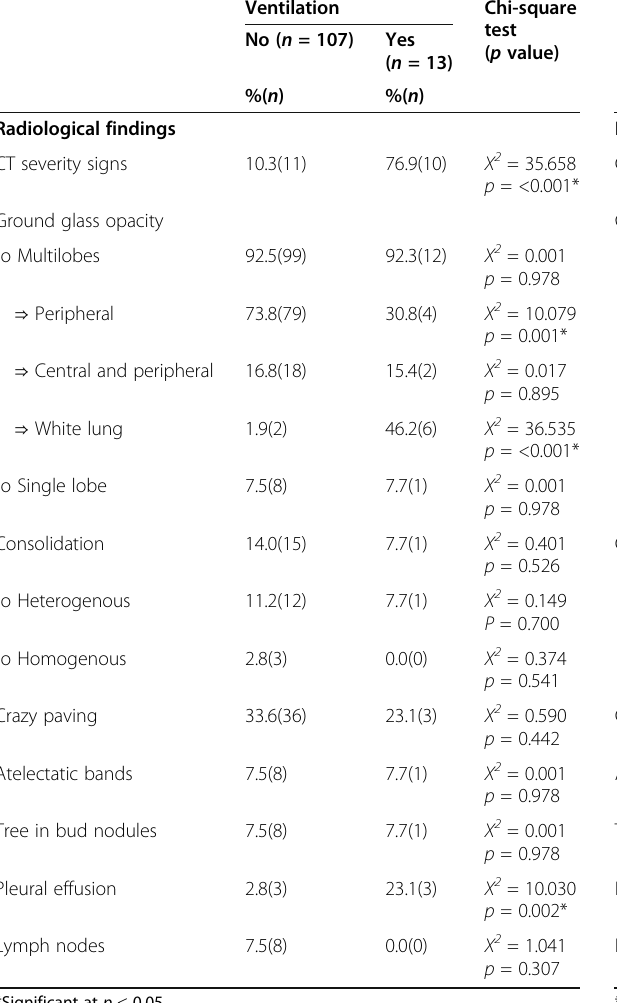
Table 6 Association between radiological findings with